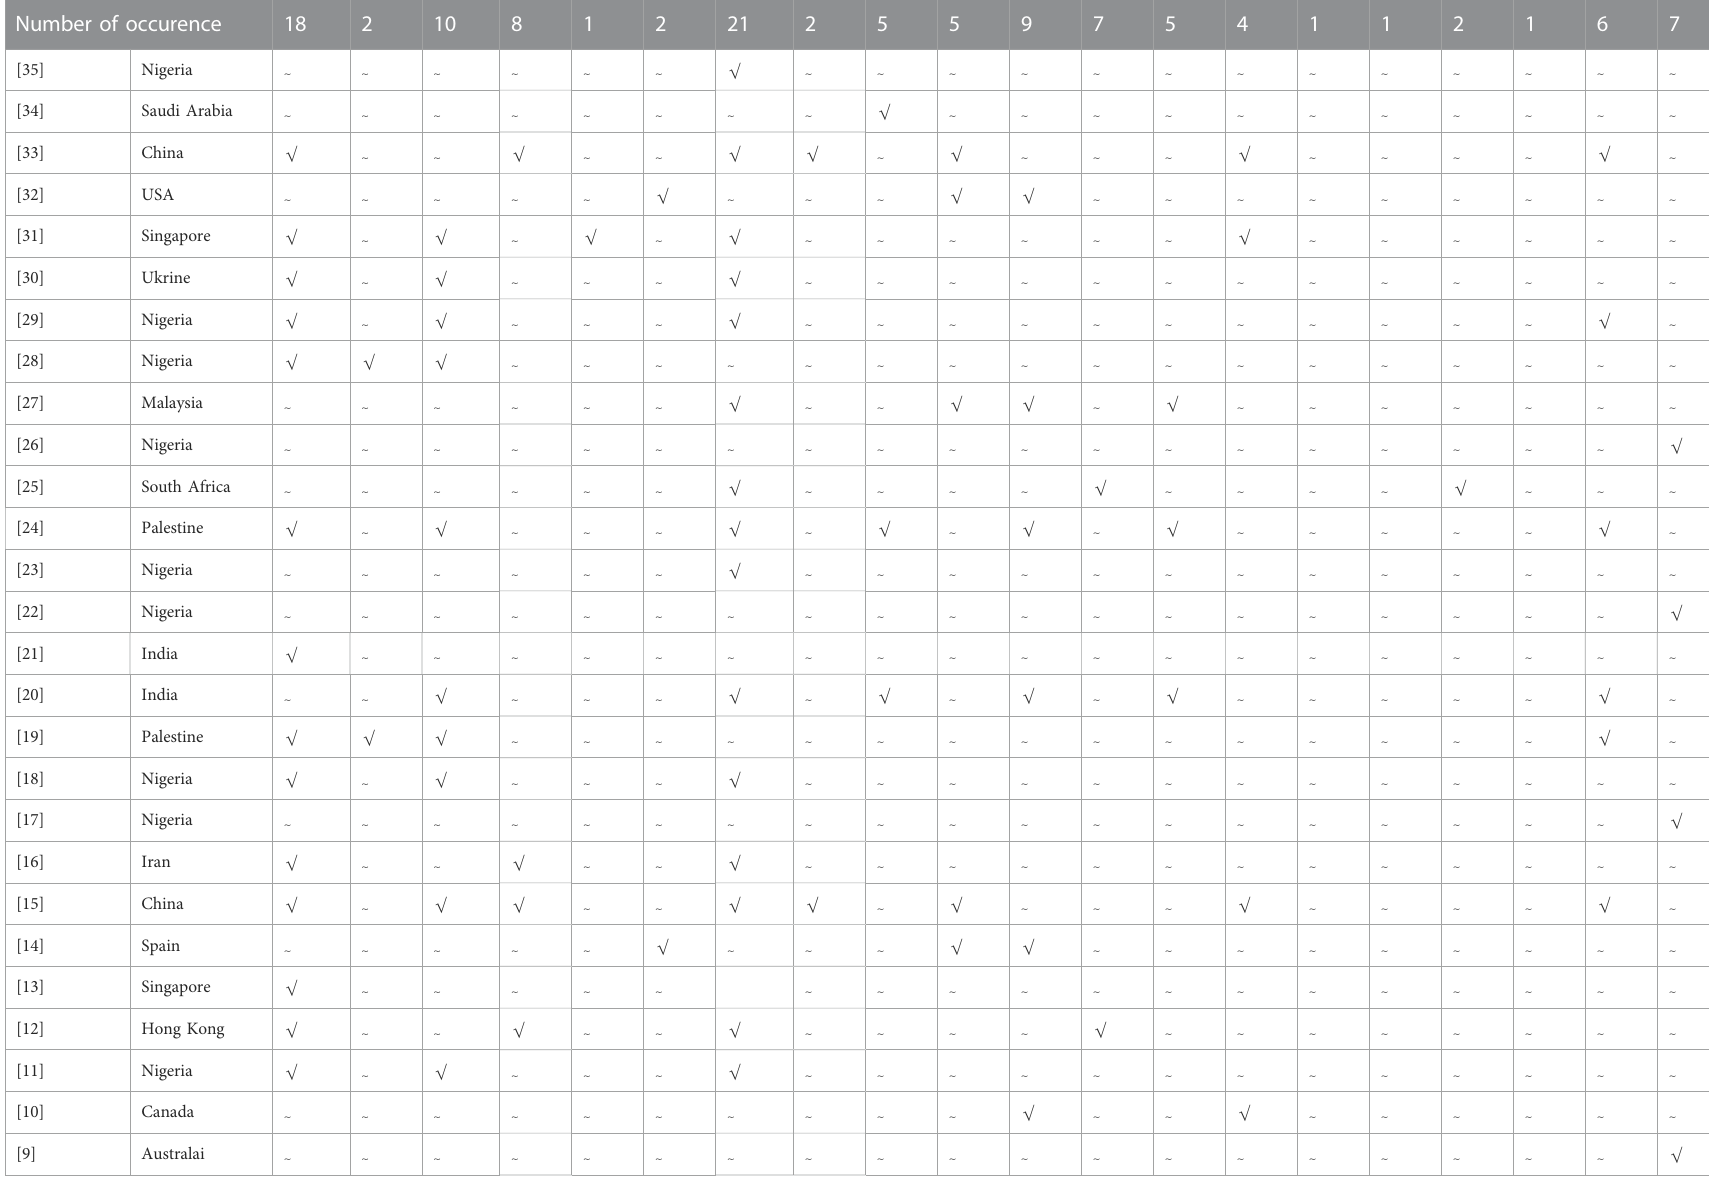
TABLE 1 An overview on the classi fi cation methods used in the reviewed papers in this study. Number of